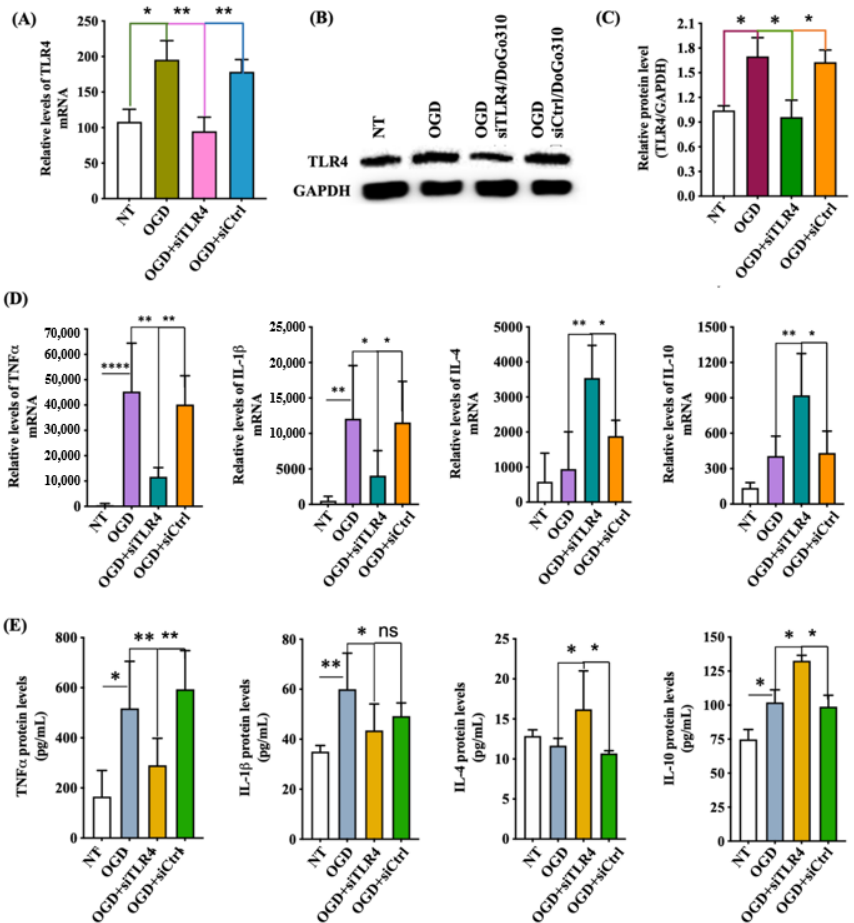
Figure 3. Mouse primary microglia polarizes to anti-inflammatory M2 phenotype through inhibiting TLR4 by siTLR4/DoGo310 complex. ( A – C ) Analysis of target gene expression by RT-qPCR and Western blot after transfection of siTLR4/DoGo310 complex; ( D , E ) silencing of TLR4 in OGD-treated microglia results in decrease in key proinflammatory cytokines, while resulting increase in anti- inflammatory cytokines, as analyzed by RT-qPCR and ELISA. NT, nontreated. NS, Not Significant. * p < 0.05, ** p < 0.001, **** p < 0.00001 compared to untreated